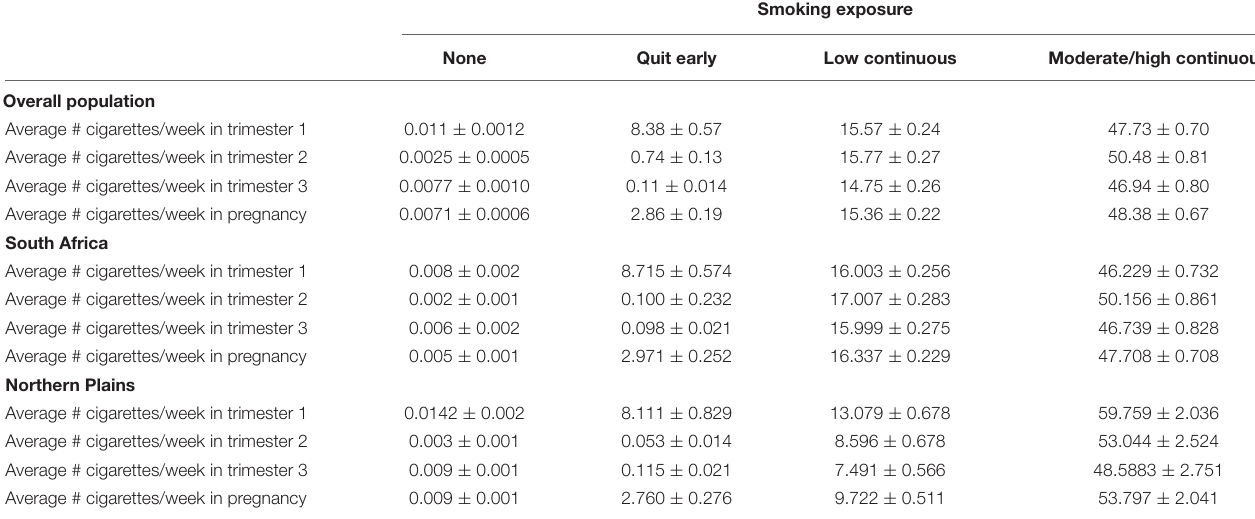
TABLE 4 | Number of cigarettes per week by trimester per smoking group in the overall population, South Africa population, and Northern Plains population.